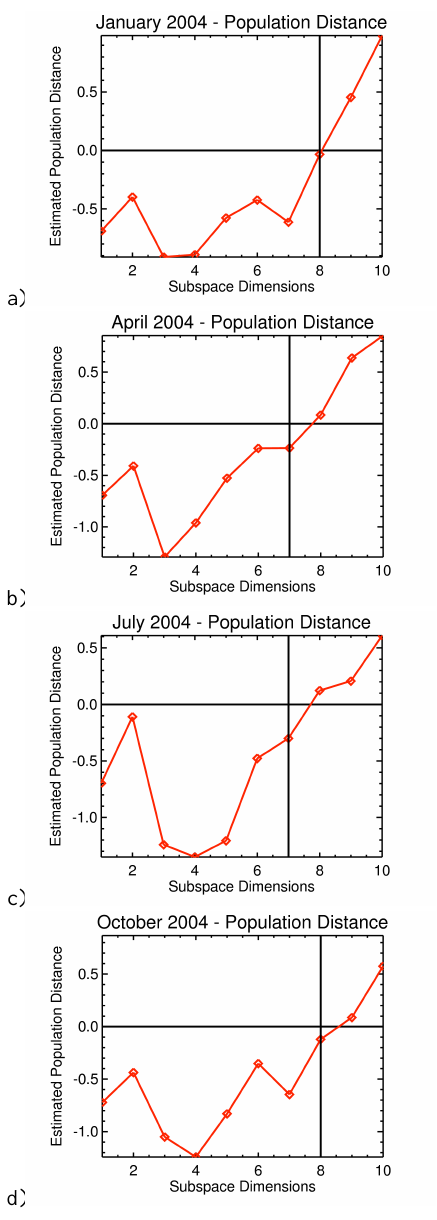
Fig. 8. The population distances between the OSSE-simulated and SCIAMACHY-observed reflectance spectra for January (a) , April (b) , July (c) , and October (d) 2004. The distances less than zero cor- respond to subspaces of k dimensions that are the same at the 95% confidence level. The vertical lines indicate the maximum number of dimensions the two data sets share at the 95% confidence level for each